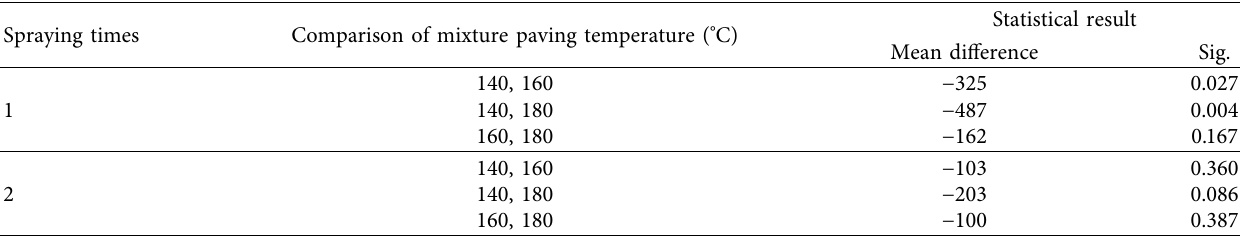
Table 6: Student’s t -test results for the influence of mixture paving temperature.